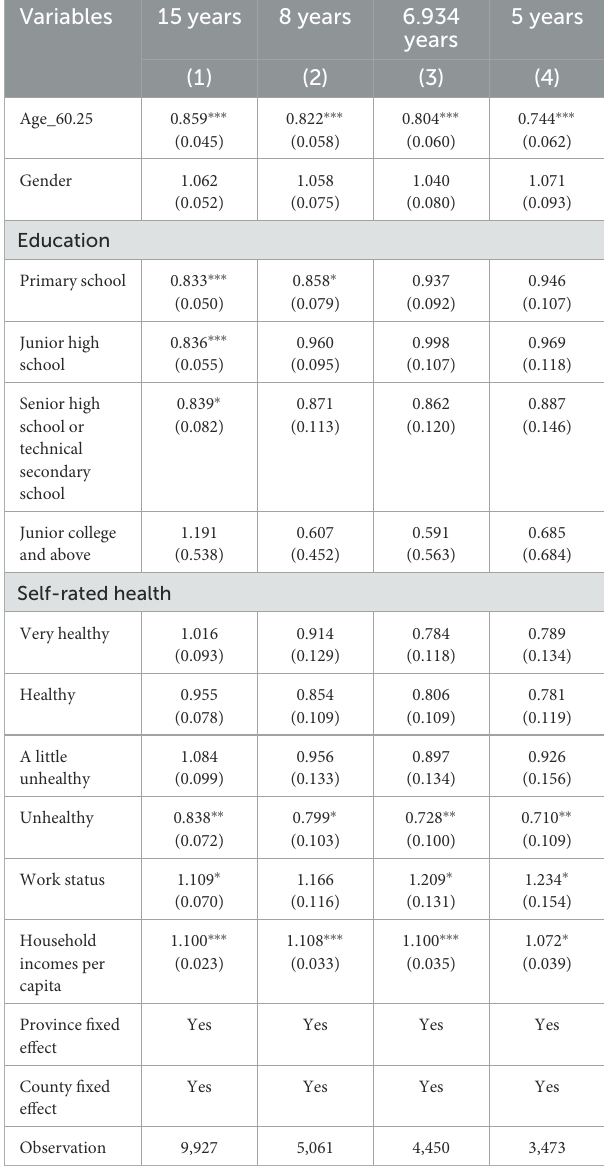
TABLE 3 The effect of the age on the intake of junk